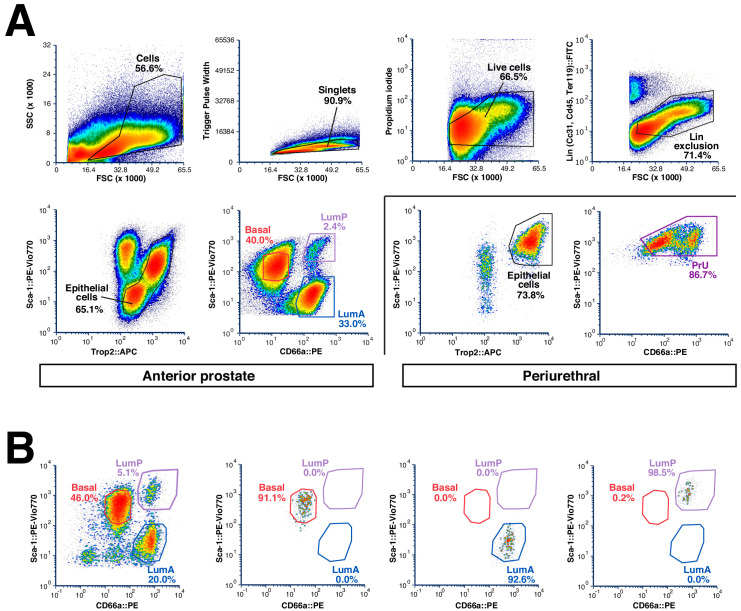
Flow-sorting strategy and validation.(A) Sorting strategy to isolate epithelial populations from each prostate lobe. Periurethral regions were removed by dissection and sorted separately. Note that basal cells in the LP and VP are not captured efficiently by this approach. (B) Representative re-sort experiment (n = 3) to confirm purity of isolated epithelial populations.